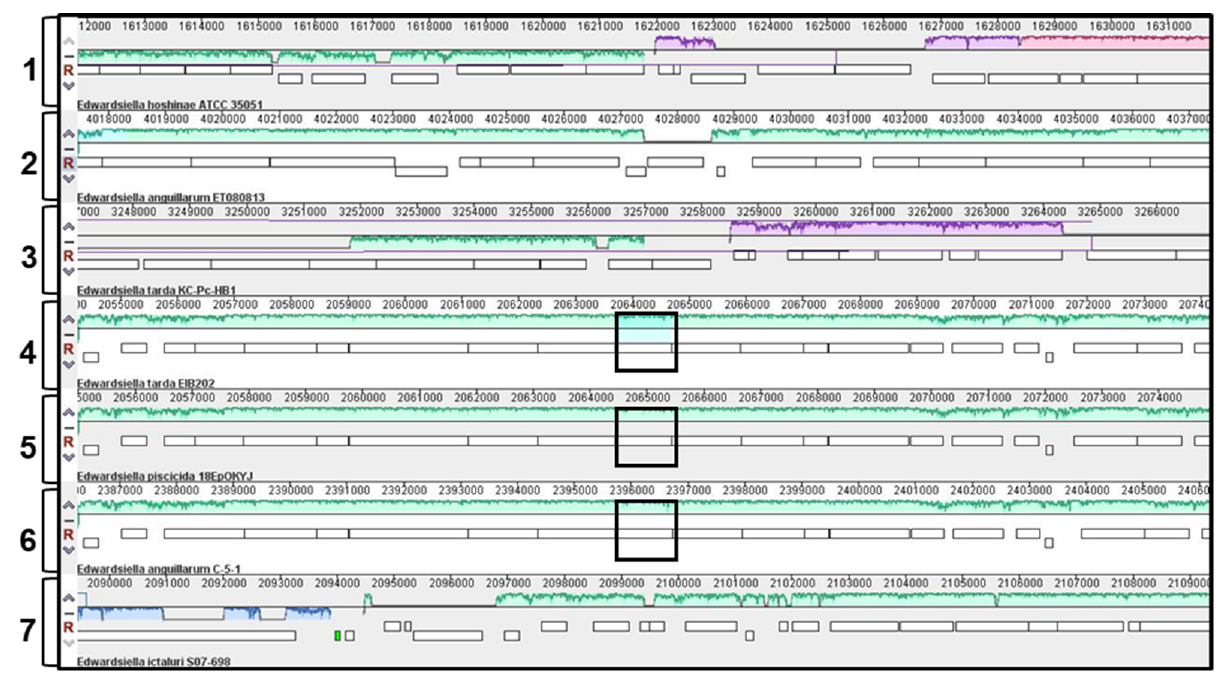
Figure 4. Comparative genomic analysis using progressive Mauve to identify the chromosomal region containing orthologous to wapG of E. tarda EIB202 in the chromosomes of E. hoshinae ATCC35051 (track 1), E. anguillarum ET080813 (track 2), E. tarda KC-Pc-HB1 (track 3), E. tarda EIB202 (track 4), E. piscicida 18EpOKYJ (track 5), E. anguillarum C-5-1 (track 6) and E. ictaluri S07-698 (track 7). Matching colors indicate homologous segments connected across genomes. Chromosomal regions inside black squares contain orthologous to wapG.